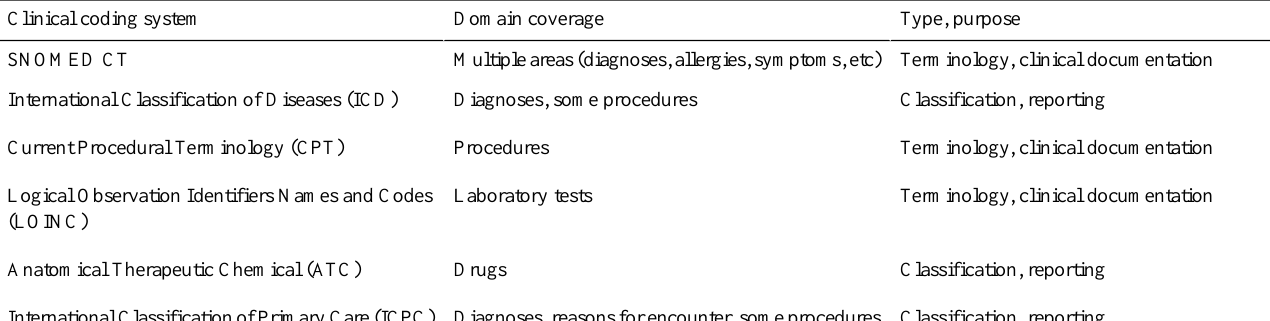
Table 1. Overview of some clinical terminologies used in electronic health records including their domain coverage and purpose. This list is not